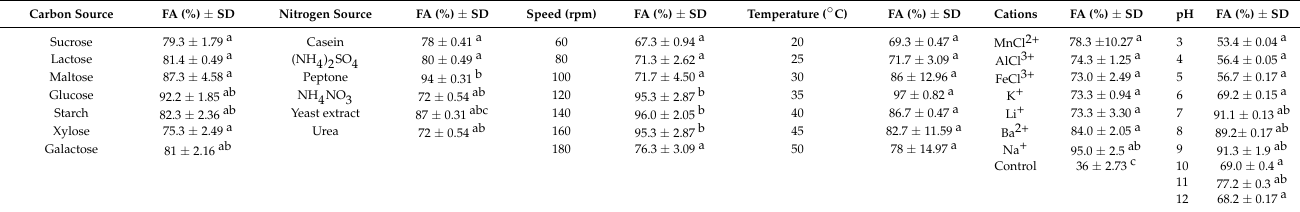
Table 1. Effect carbon and nitrogen sources, speed, temperature, cation, and pH on flocculation .